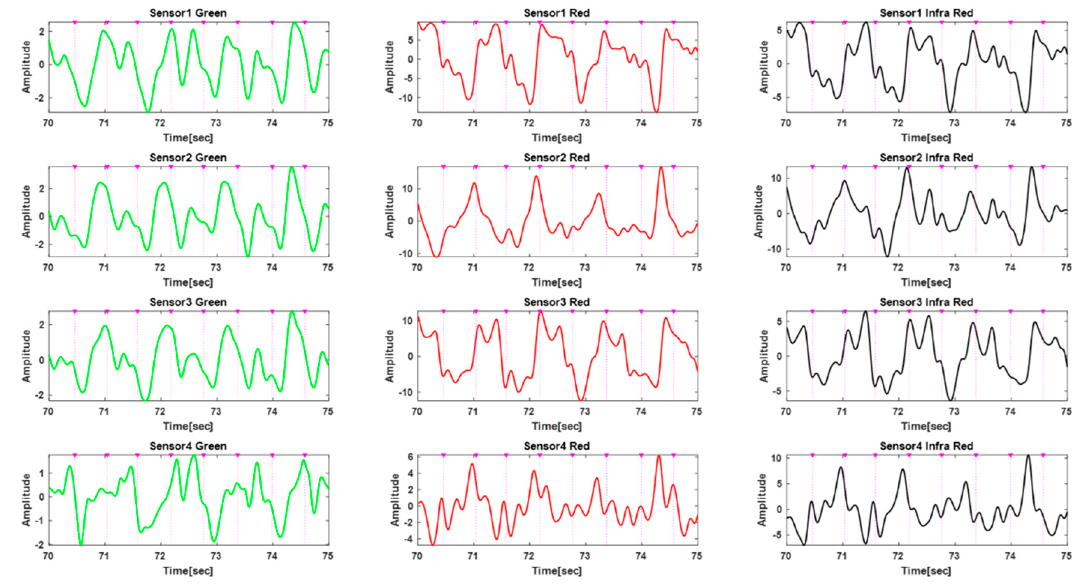
Figure 6. Twelve ‐ channel PPG signals measured while running at about 8 km/h.